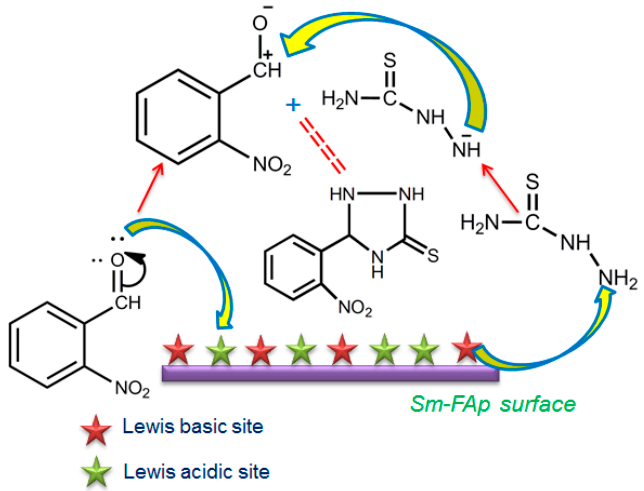
Figure 7. Perspective view of Sm-FAp surfaces facilitating the reaction.